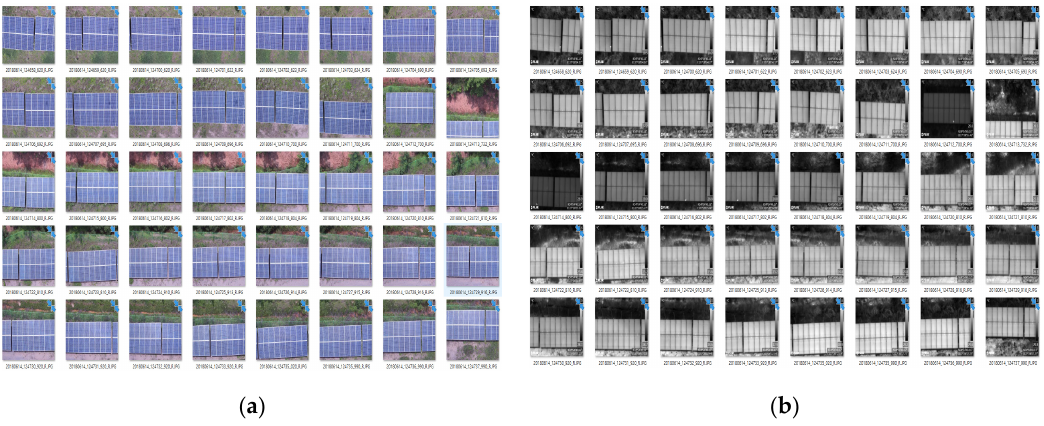
Figure 14. Samples for experiment: ( a ) visible image samples; ( b ) thermal image samples.